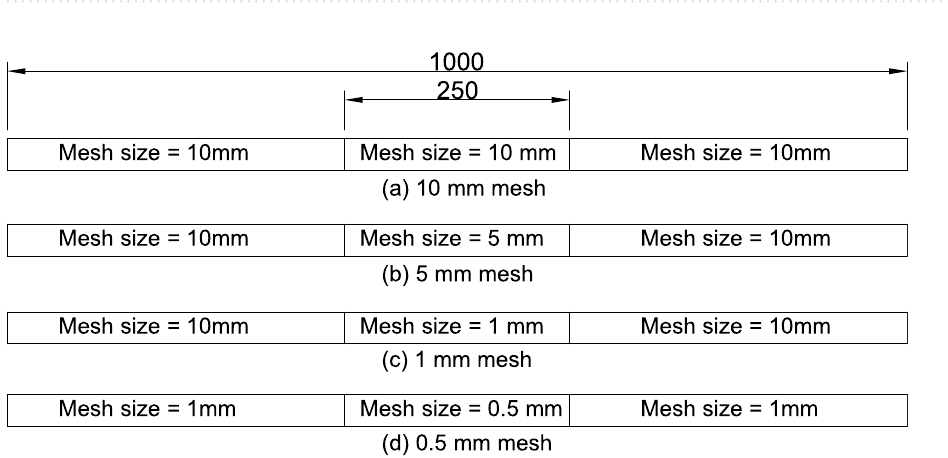
Figure 9. Boundary condition, loading condition, geometrical size (mm), and mesh distribution of the example model.